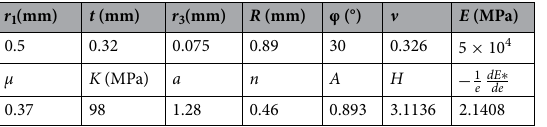
Table 3. Related parameters of the analytical model for tensile strength of crimping